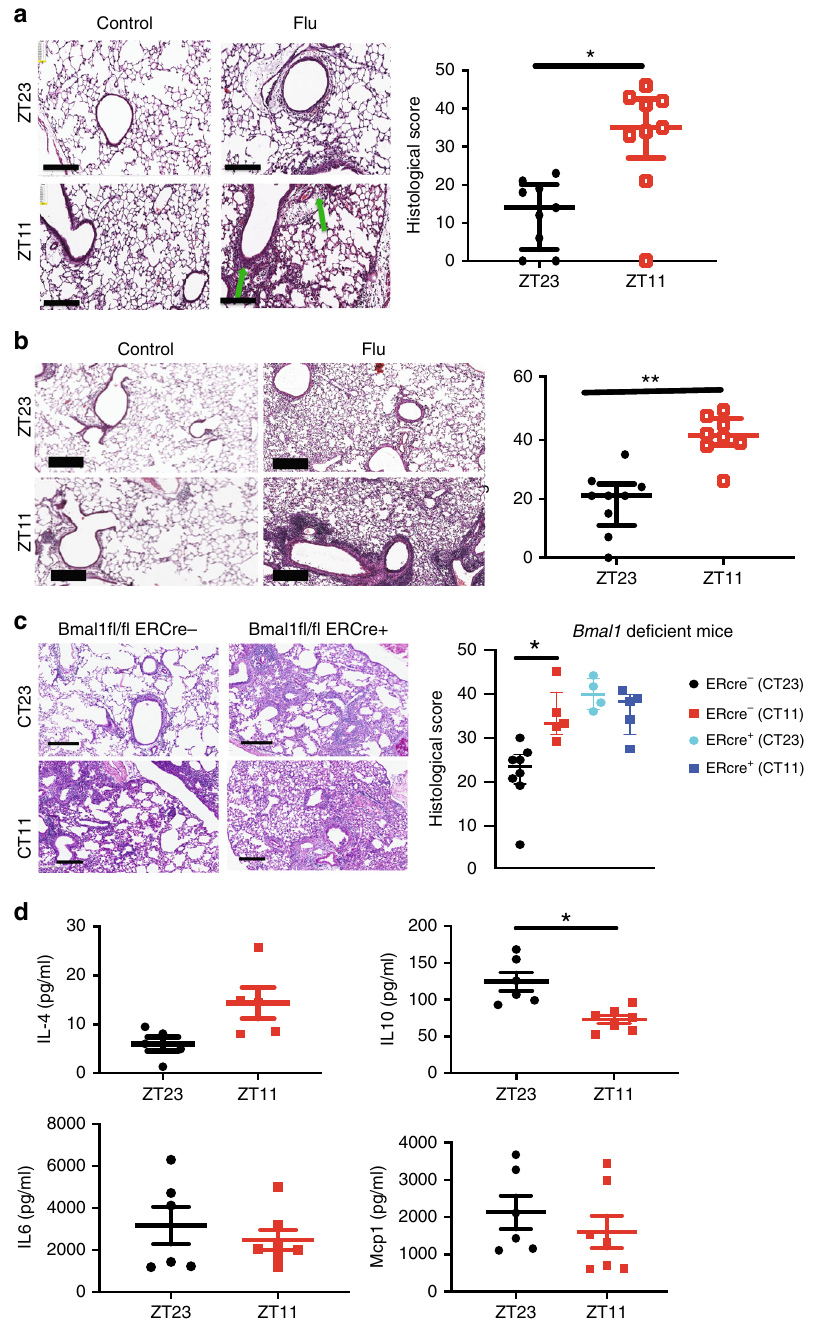
Fig. 3 Temporal gating of IAV is associated with lung in fl ammation. a Top panel: representative micrographs of H&E stained lung sections 2 days after sham (PBS) or IAV (40 PFU) treatment (photomicrograph bar = 200 µ m). Lower panel: severity of lung injury quanti fi ed using an objective histopathological scoring system by a researcher blinded to study group ( n = 5 – 6/group; Wilcoxon rank-sum test; * p < 0.05, ZT23 vs. ZT11). b Top panel: representative micrographs of H&E-stained lung sections 6 days after sham (PBS) or IAV (40 PFU) treatment (photomicrograph bar = 200 µ m). Lower panel: severity of lung injury quanti fi ed as above ( n = 7 – 9 mice/group; Wilcoxon rank-sum test; ** p < 0.01, ZT23 vs. ZT11). c Top panel: